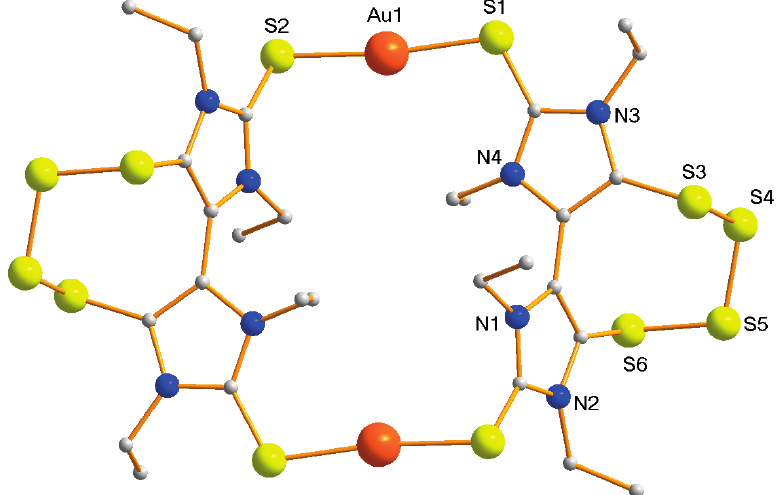
Figure 2. Molecular structure of the compound 2 , with the atom labeling scheme (hydrogen atoms omitted for clarity).